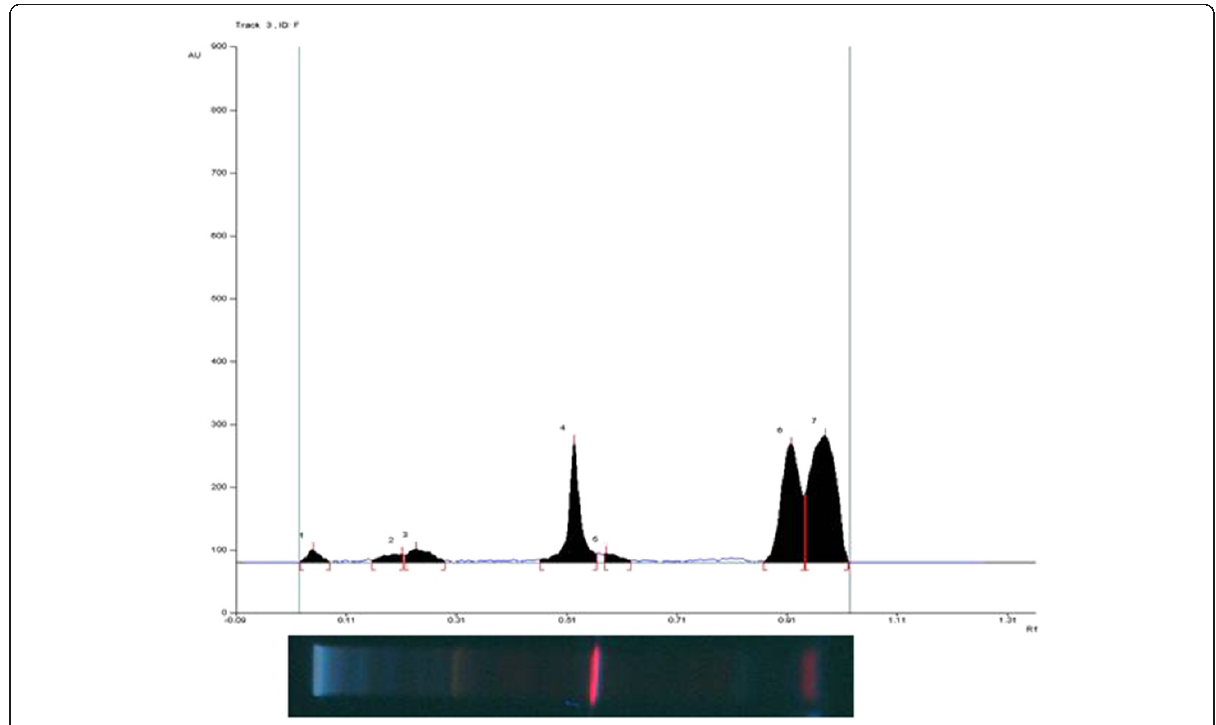
Figure 1 HPTLC Fingerprint of Nuna Kadugu.